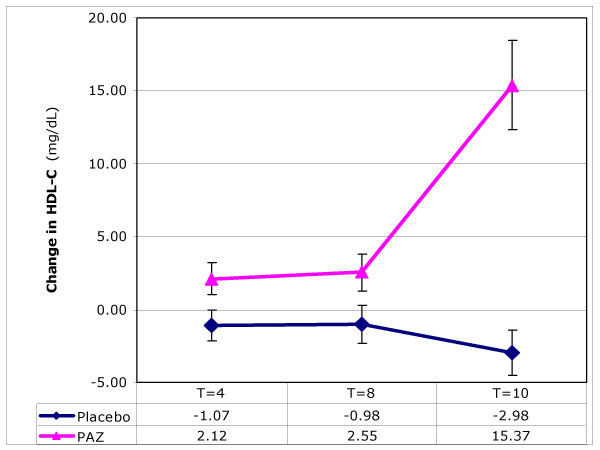
The effect of ProAlgaZyme vs. placebo on HDL-cholesterol (mg/dL). Values are mean change at 4, 8 and 10 weeks compared to baseline within 95% confidence limits (+/- 1.96*(standard error of the mean)).